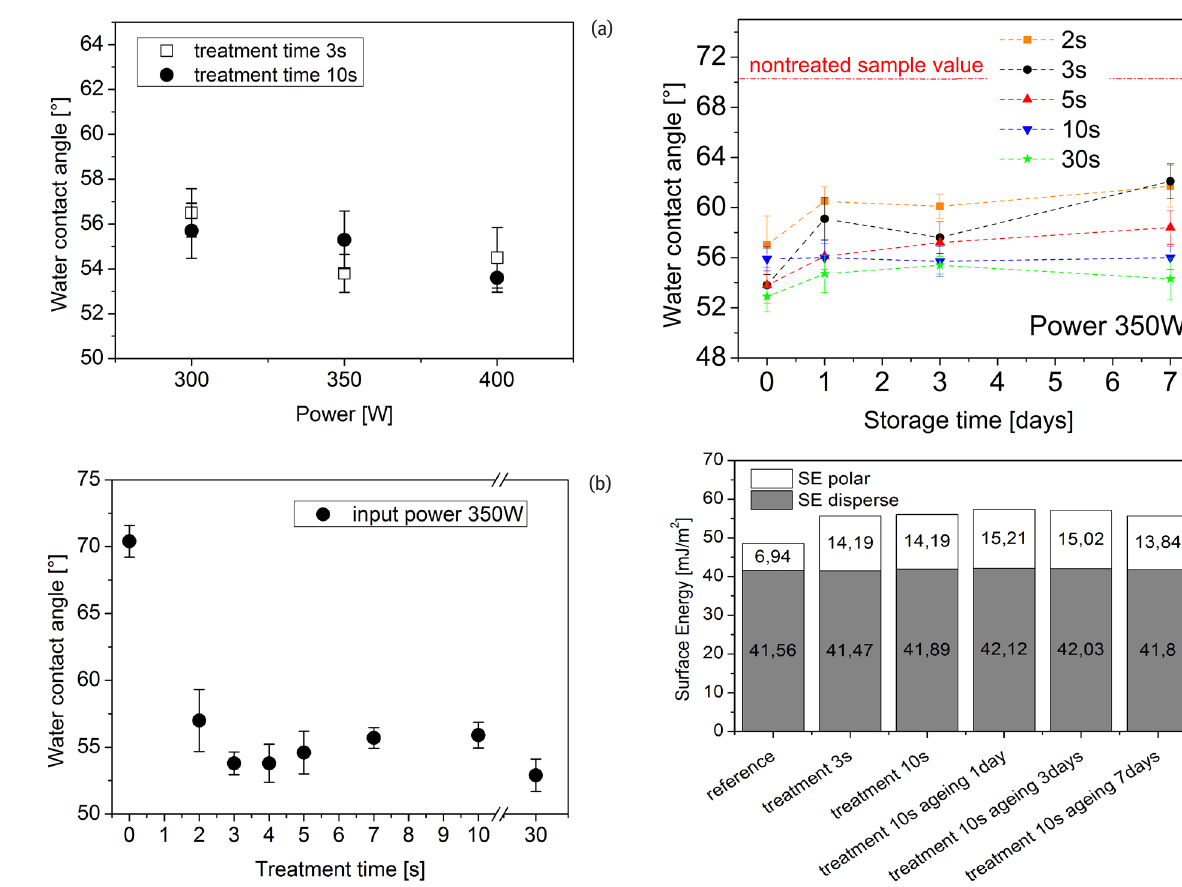
Figure 2 : DCSBD plasma treated PLA: WCA dependence on a) input power; b) treatment time.